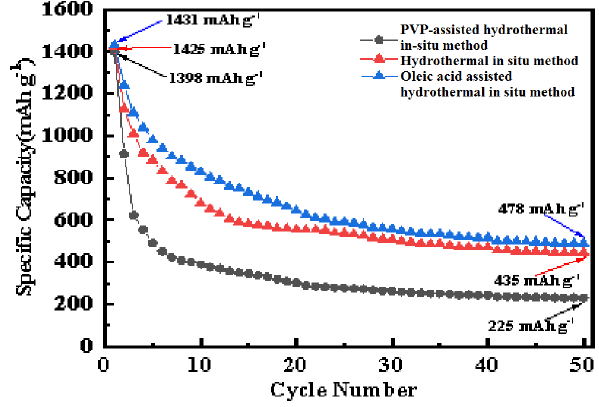
Figure 5: Cycle curves of Fe 2 O 3 /rGO anode materials prepared by three hydrothermal